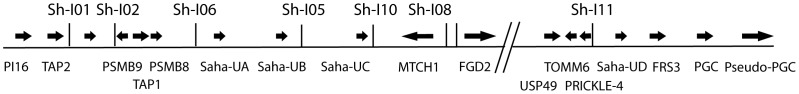
Location of eight MHC-linked microsatellites on devil chromosome four, associated with the MHC region.Six of these (Sh-I01, Sh-I02, Sh-I05, Sh-I06, Sh-I10 and Sh-I11) are located close to the four MHC class I loci (Saha-UA, Saha-UB, Saha-UC and Saha-UD) and several other genes involved in antigen presentation (TAP1, TAP2, PSMB8, PSMB9). The two remaining markers (Sh-I07, Sh-I08) are more closely linked with genes within the MHC that do not play a direct role in antigen presentation (MTCH1, FGD2).